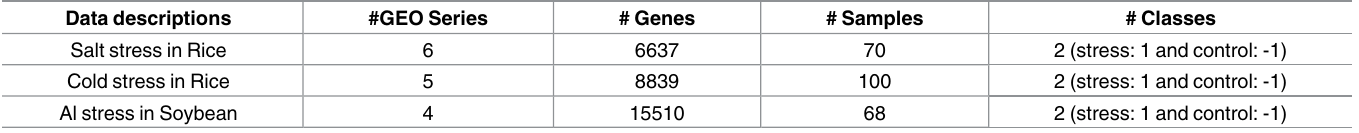
Table 1. Microarraystudies used in comparative